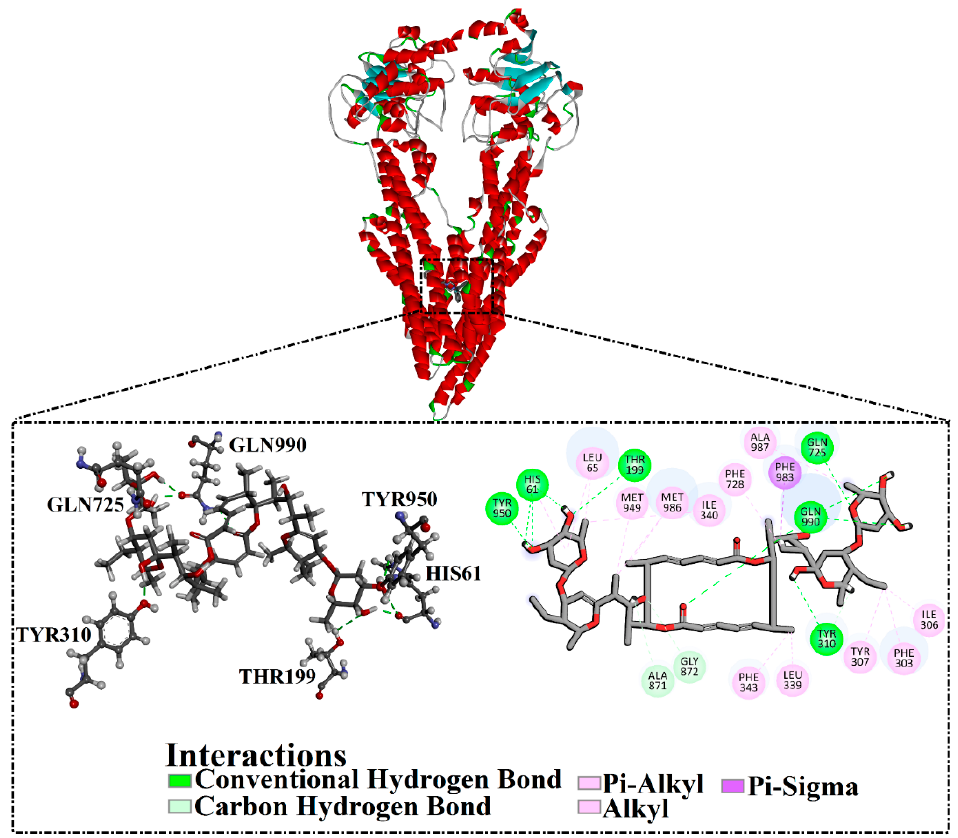
Figure 3. 3D and 2D molecular interactions of the predicted binding mode of NPC197736 within the ABCB1 transporter.